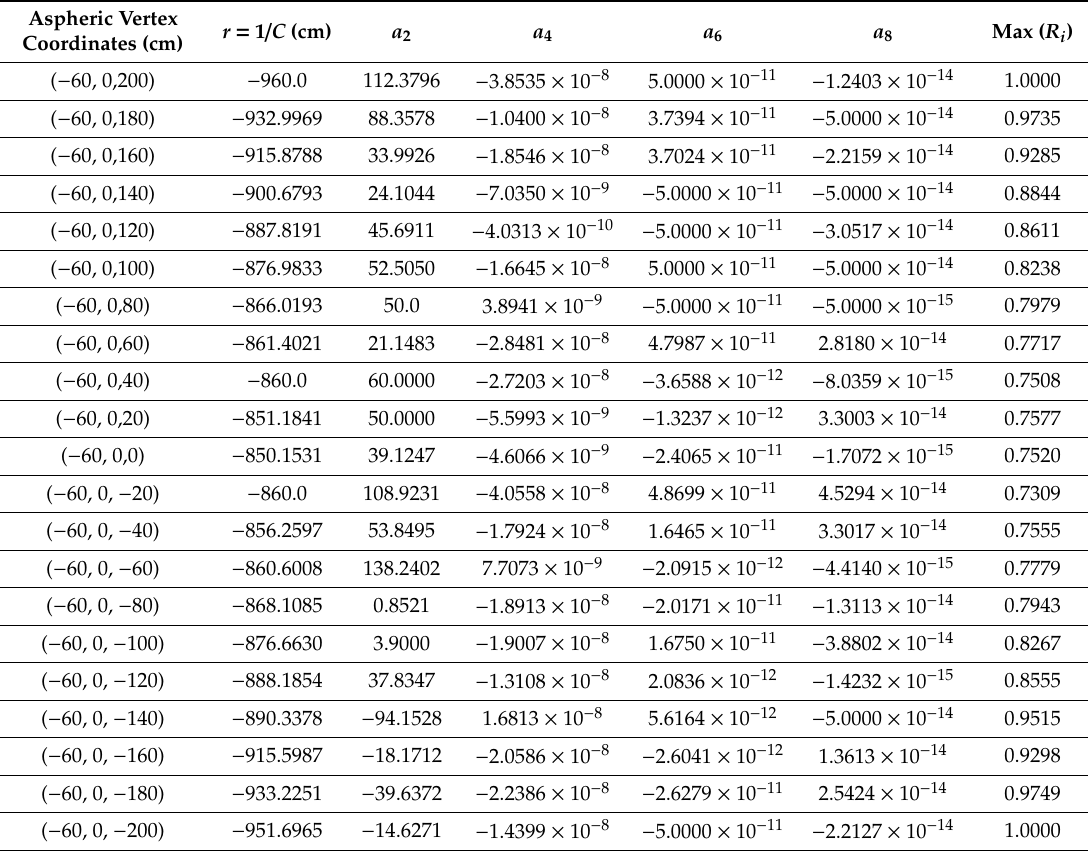
Table 1. The parameters of aspheric reflectors whose vertices are located at different positions obtained with the particle swarm optimization algorithm.